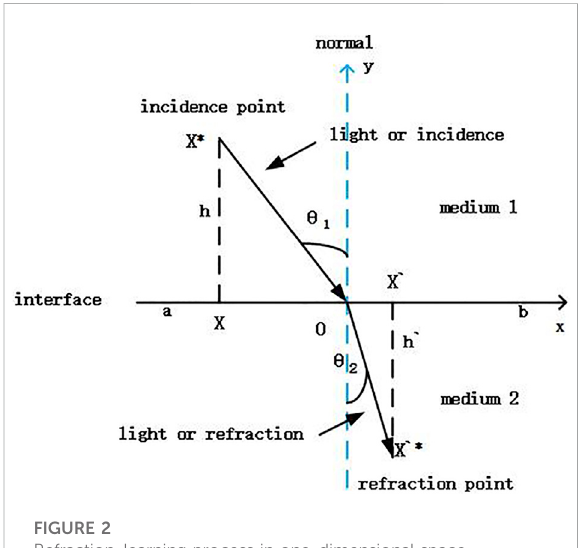
FIGURE 2 Refraction-learning process in one-dimensional